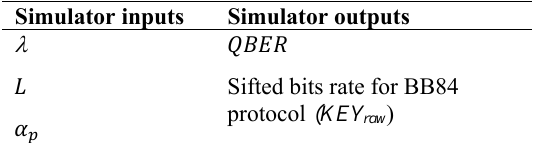
Inputs and outputs for the optical quantum channel